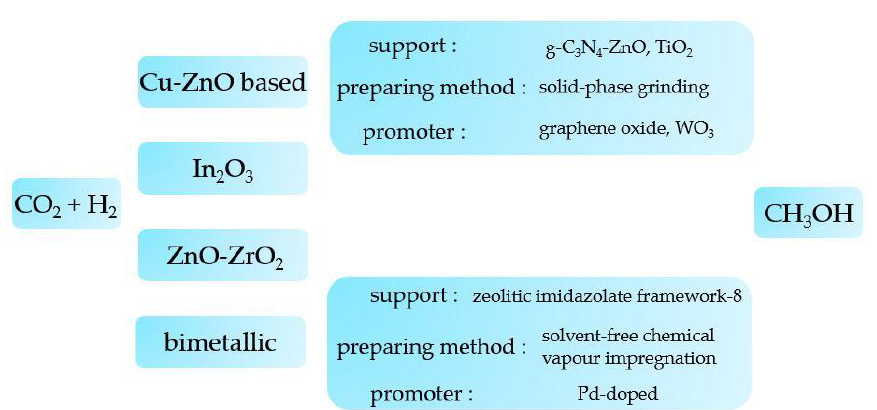
Figure 9. Catalytic system for the direct hydrogenation of CO 2 to CH 3 OH in this review.